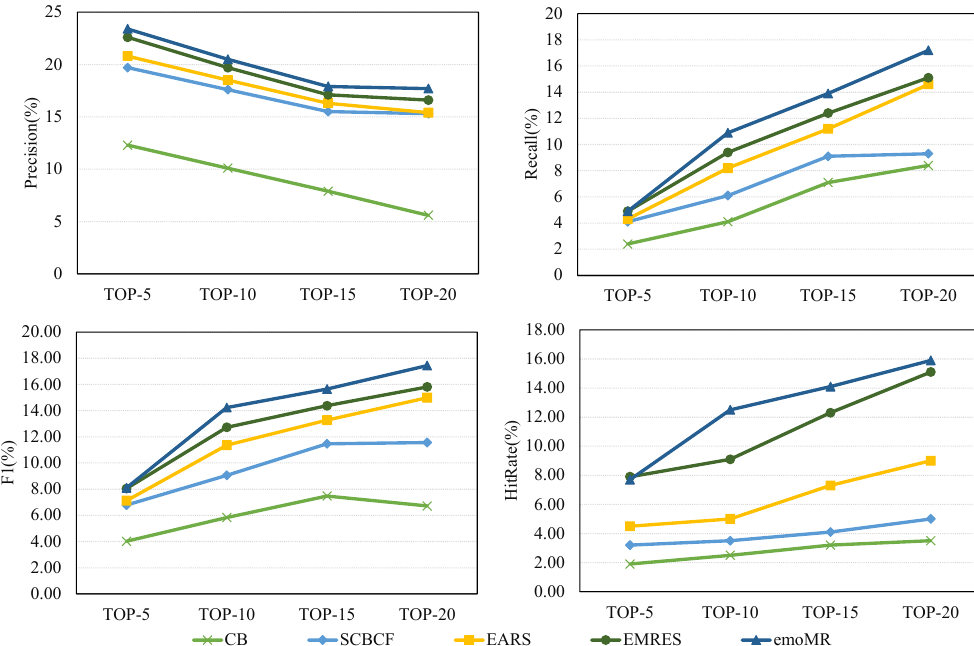
Figure 10. The performance comparison of the methods in the Top-n recommendation